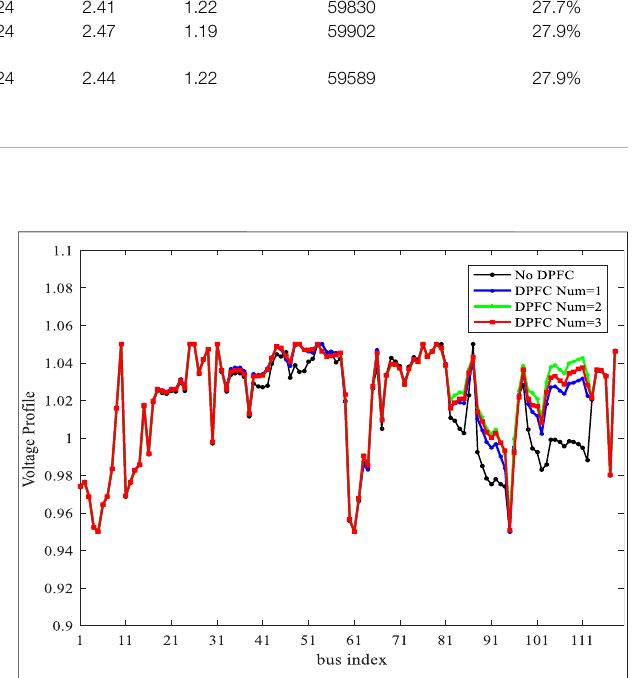
FIGURE 12 | Voltage pro fi le w/o DPFC under s15 scenario.